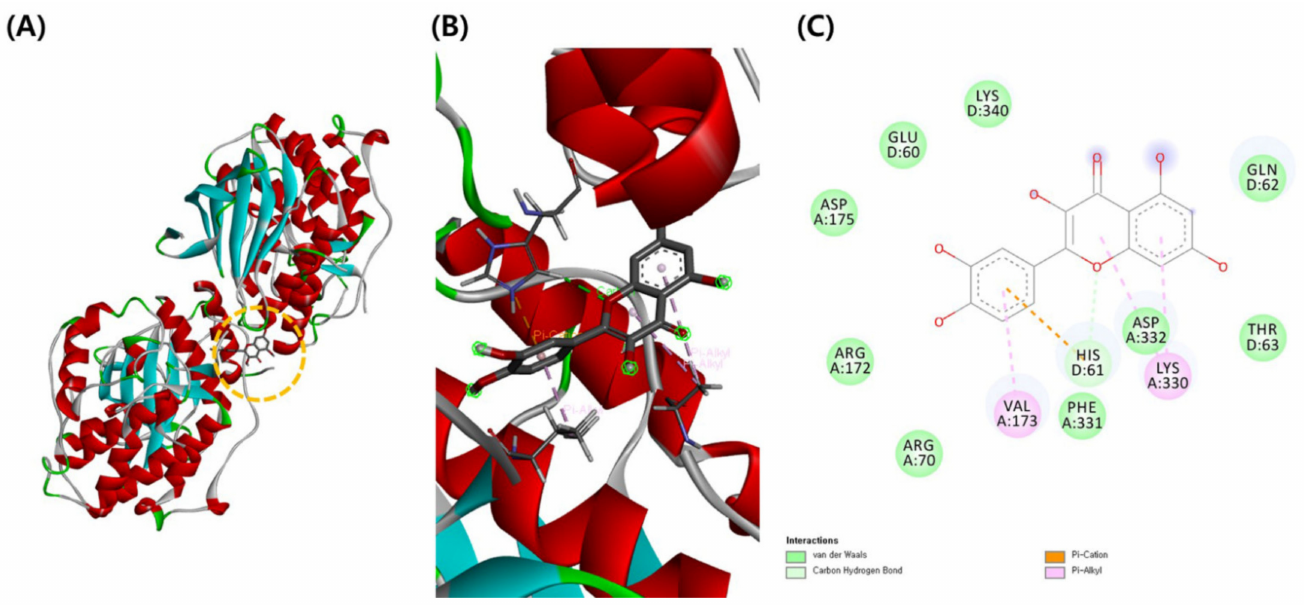
Figure 4. Ligand–receptor binding simulation of quercetin and target (MAPK1) using Discovery Studio Visualizer. ( A ) The 3D representation of quercetin–MAPK1 interaction. ( B ) 3D representation of quercetin bound to MAPK1 receptor site. ( C ) The 2Drepresentation of quercetin–MAPK interaction tagged with key